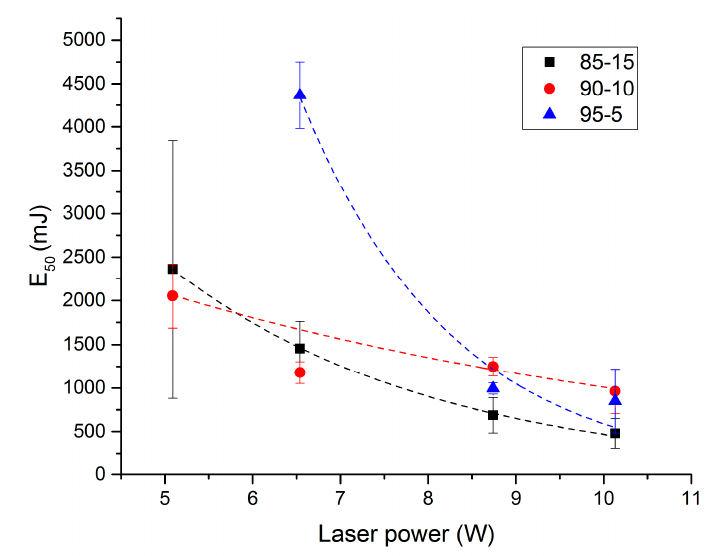
Figure 14. Ignition probability of 50% (E 50 ) as a function of laser power for the three propellants, P0 = 50 bar of Ar.